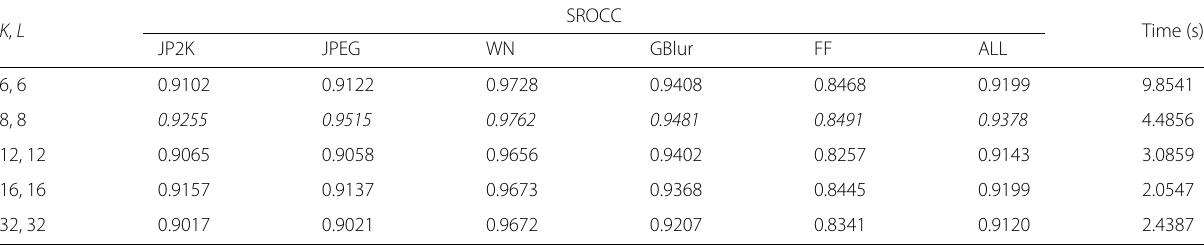
Table 3 Median SROCC value of ENIQA on the LIVE database with different window sizes